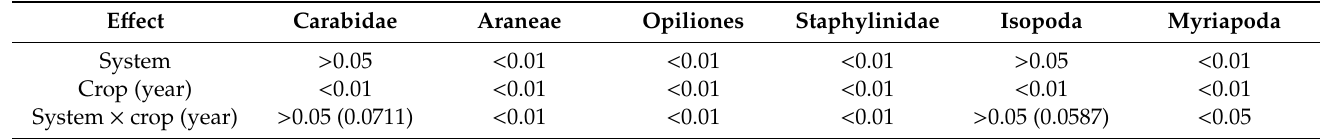
Table 7. Results of the mixed model analysis on arthropod taxa (P levels). See material and methods for explanations.